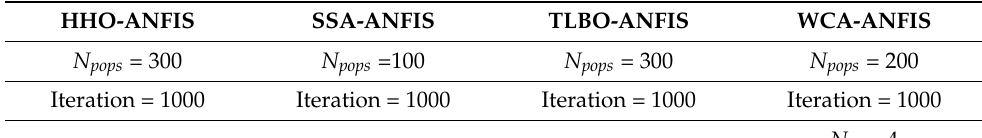
13 Table 2. Parameters of the implemented algorithms. HHO-ANFIS